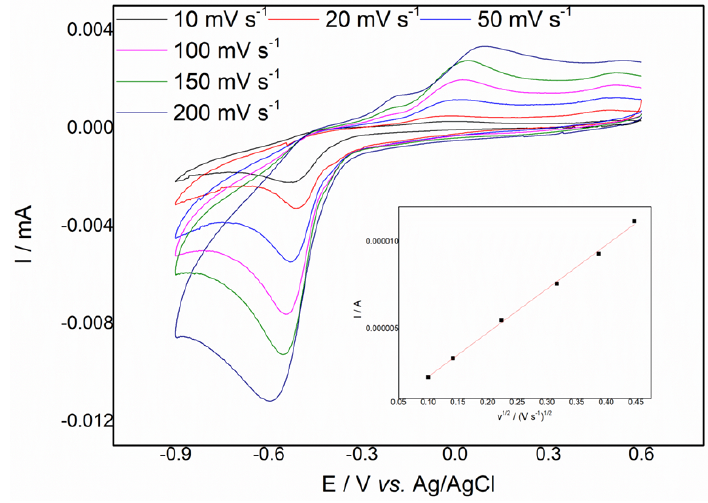
Figure 6. Cyclic voltammetry at different scan rate for the reduction of sulfite of 5 mmol L − 1 in BRB (pH 1.81) on MWCNT/IL/MO.